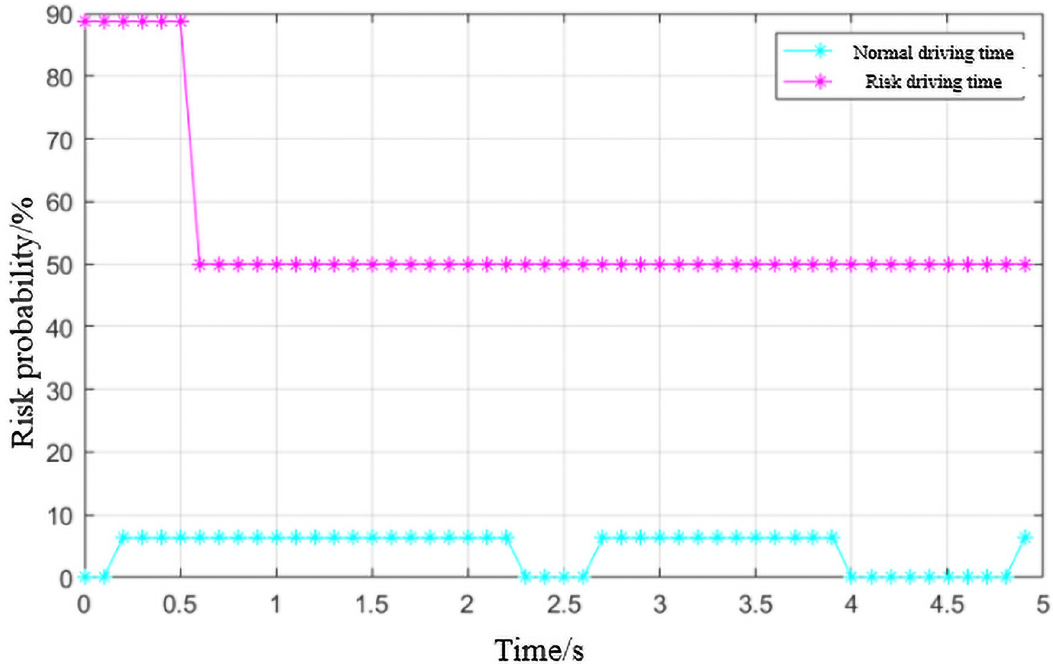
Fig 13. Vehicle operation risks in different time periods.